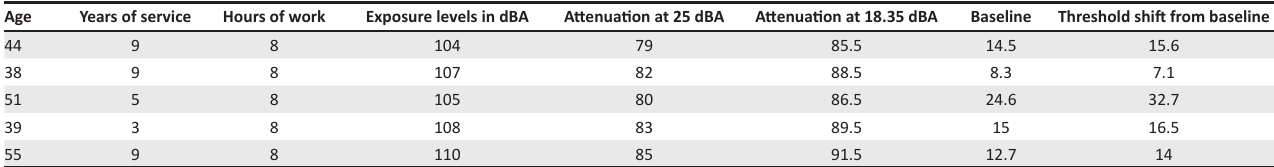
TABLE 1: Rock driller operators’ threshold shift for a deep platinum mine in South Africa. Age Years of service